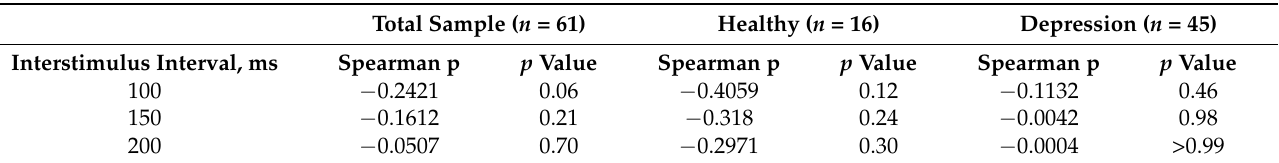
Table 2. Association between the cortical silent period and long-interval intracortical inhibition in youth.